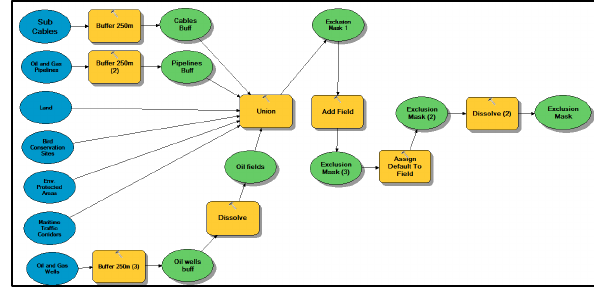
Figure 5: diagram of area exclusion model